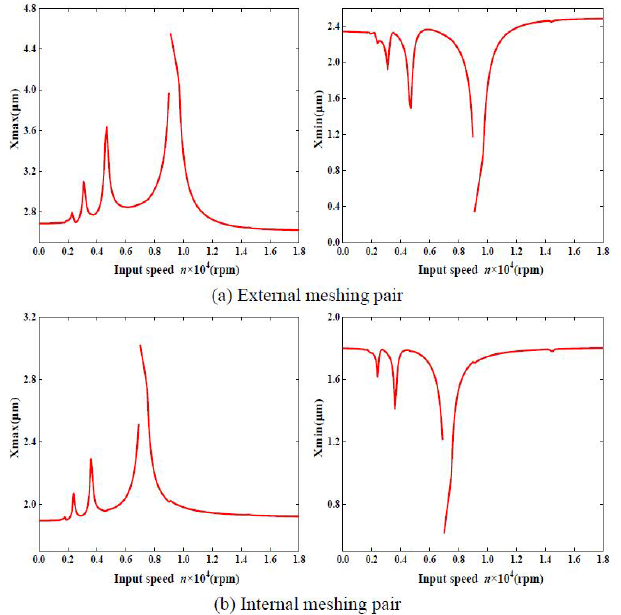
Figure 7. Effect of damping on the vibration response curve.